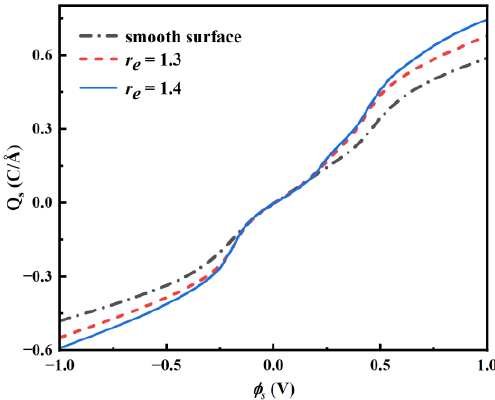
Figure 8. Surface charge as a function of 𝜙 𝑠 , X BF4 = 0.2.